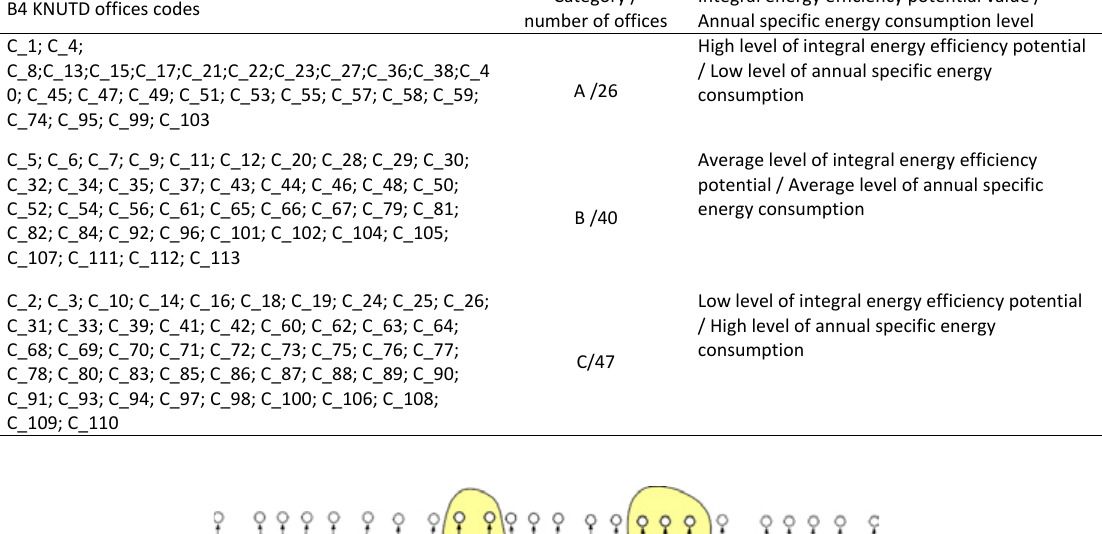
Table6: Energy certification of 113officesof KNUTD building B4 according to categories A, B, C (STATISTICA 10 listing) Table 6: Energy certification of 113 offices of KNUTD building B4 according to categories A, B, C (STATISTICA 10 listing)